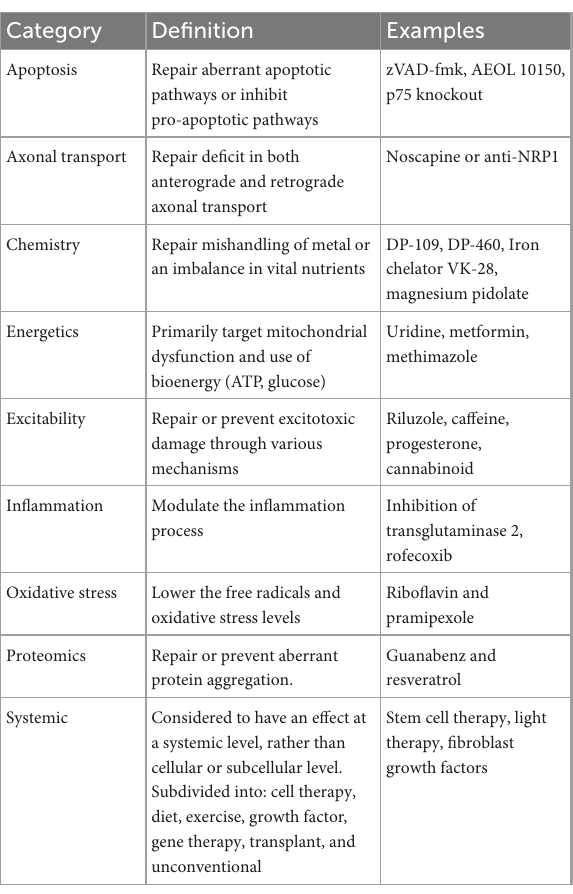
TABLE 1 Pathophysiological treatment categories, definitions, and